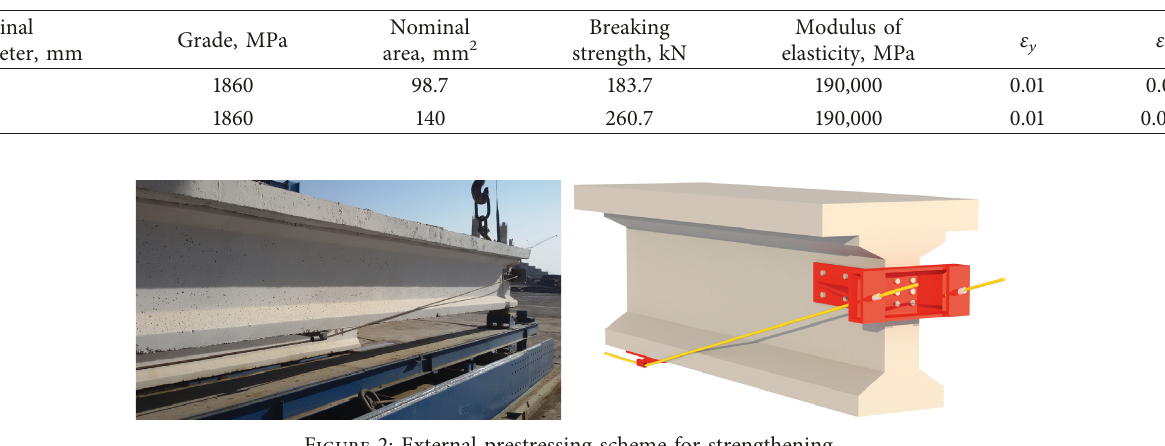
Table 2: Properties of the strands.